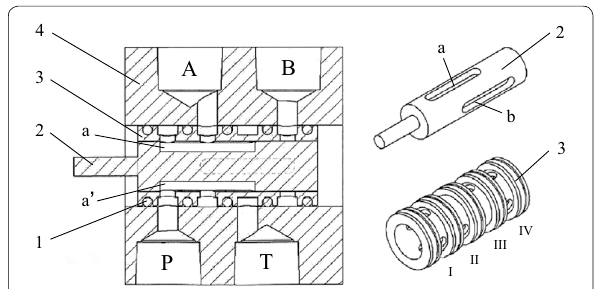
Figure 11 High-frequency rotary-valve. 1. O ring; 2. Spool; 3. Valve sleeve, 4. Valve body